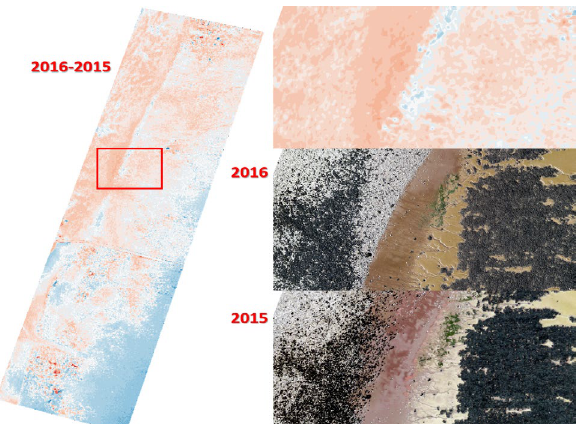
Figure 14 Erosion and Accretion Map for the UAV Derived Models Between 2016 and